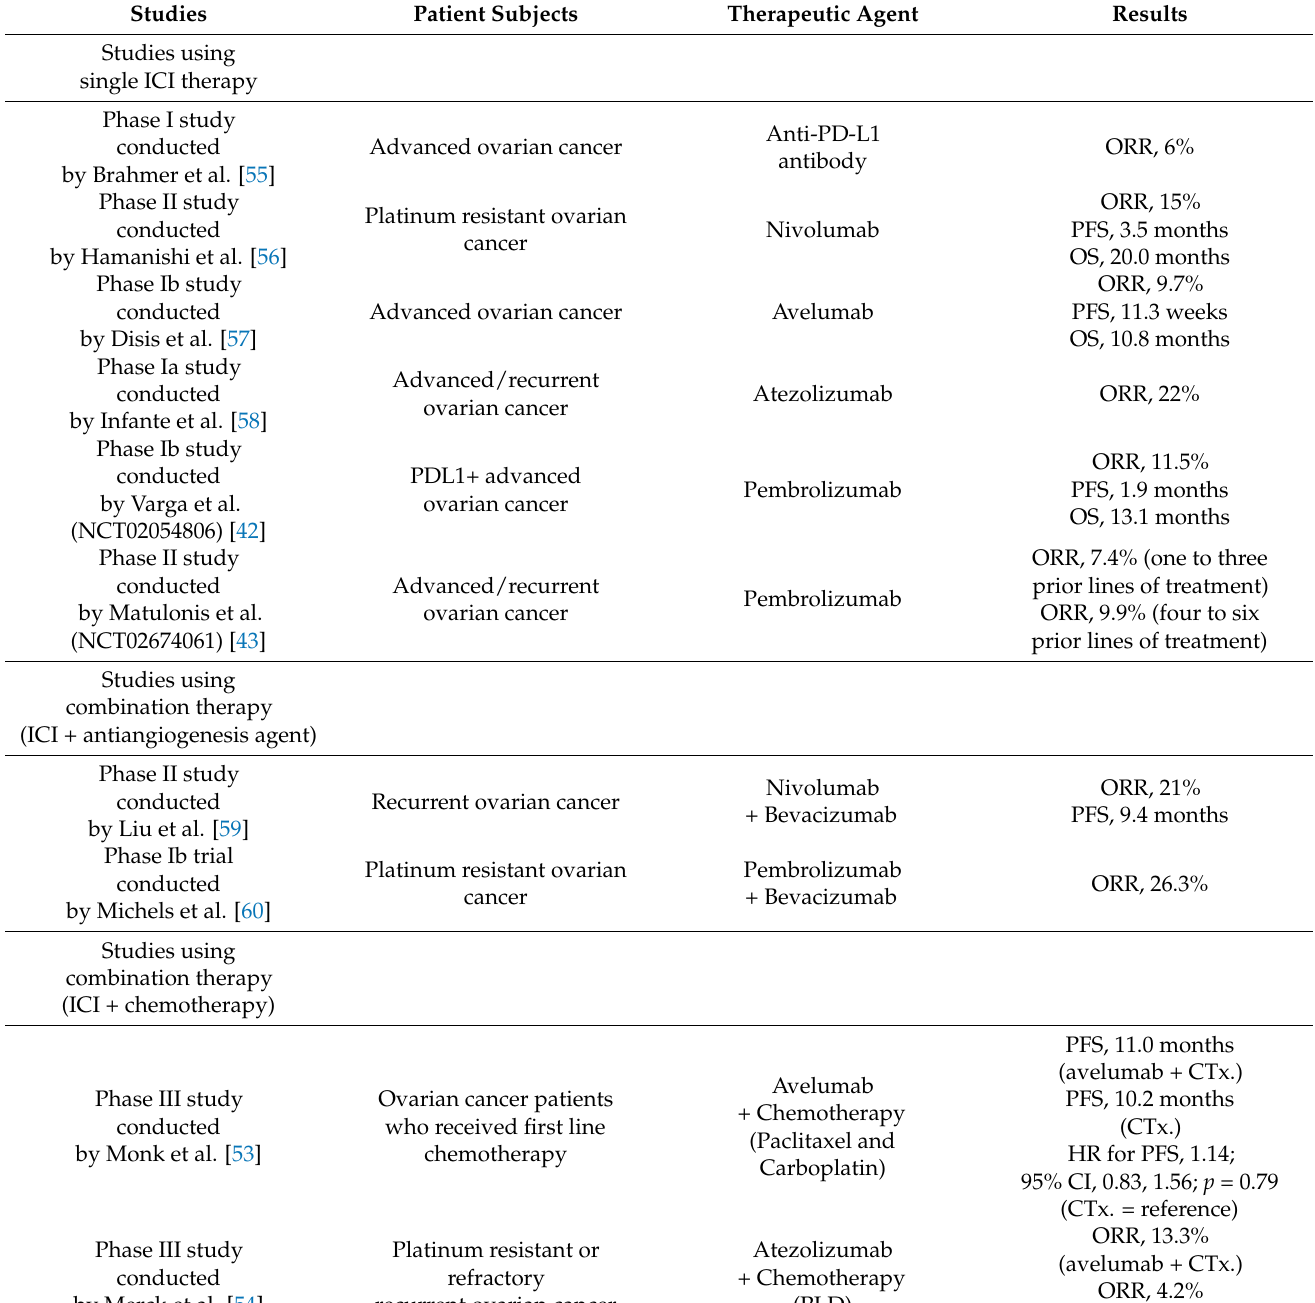
Table 2. ICI monotherapy and Combination therapy, including ICI applied to ovarian